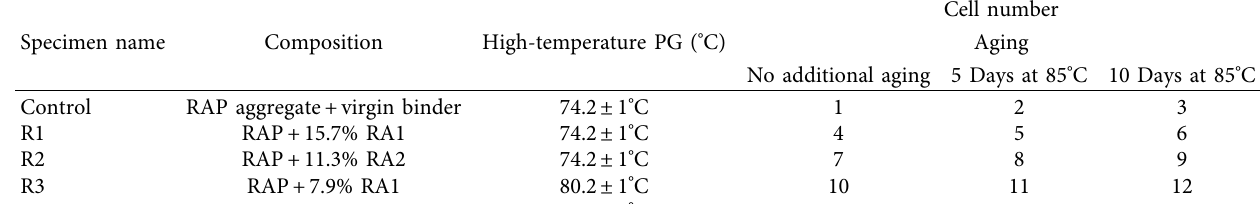
Table 3: Factorial design of the experiment.